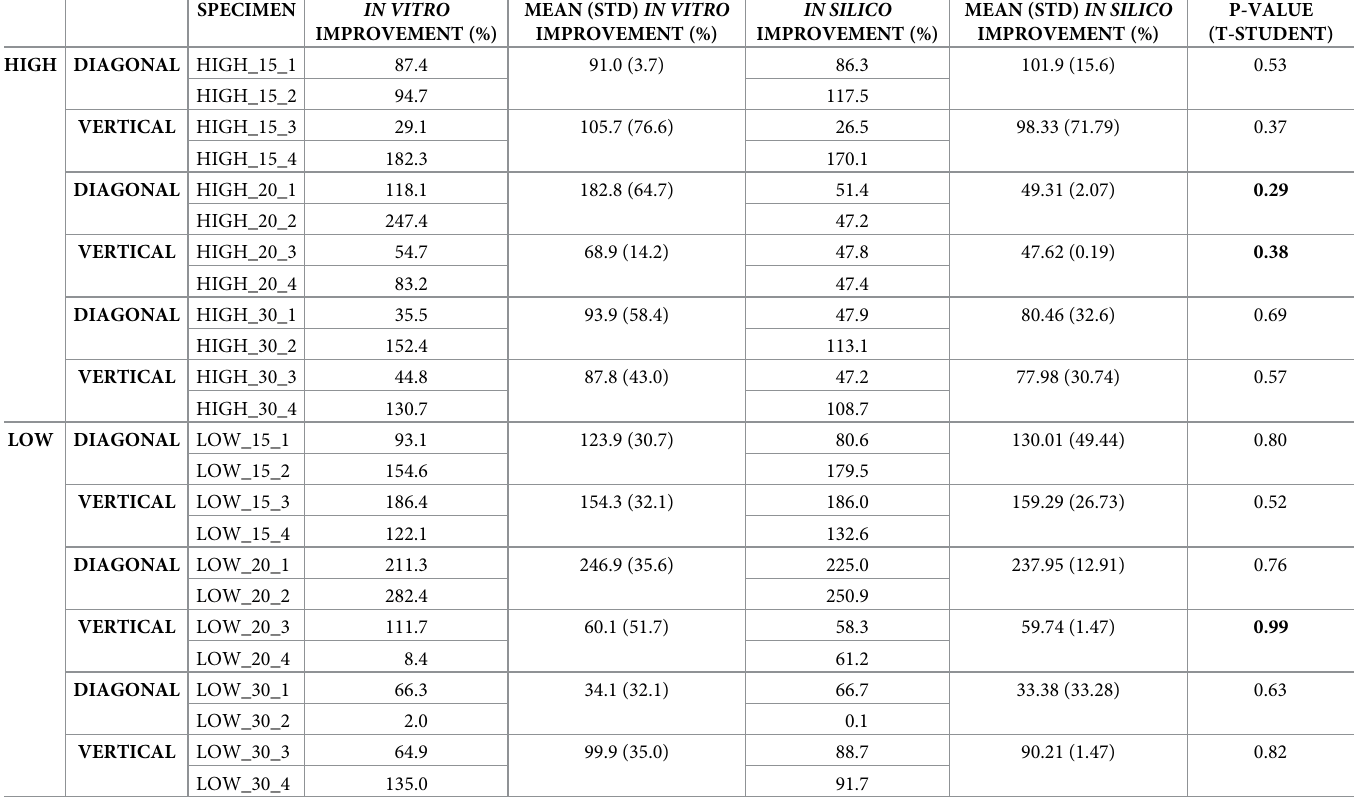
Table 2. Mean Young’s modulus improvement (%) in all the cases tested in vitro and in silico. STD indicates standard deviation. Bold numbers in the p-value column indicated a negative (-1) Pearson correlation coefficient. SPECIMEN IN VITRO IMPROVEMENT